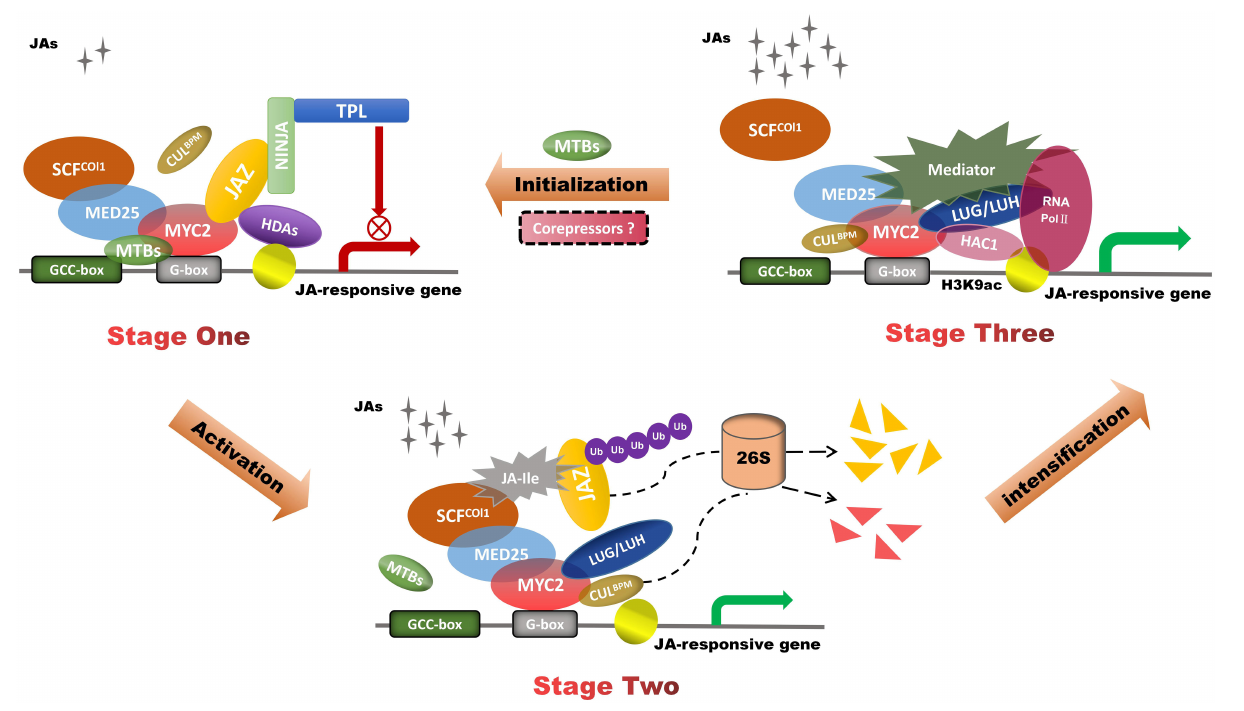
FIGURE 2 | JAZ and MED25 mutually regulate JA-induced transactivation of MYC2-targeted genes. In Stage one, the MED25–MYC2 interaction is relatively weak because JAZ competes with MED25 for interaction with MYC transcription factors. In Stage two, COI1–JAZ co-receptor complex leads to proteasome-dependent degradation of JAZ repressors, which participate in the degradation of JAZ by 26S proteasome. In Stage three, MED25 recruits Pol II and LUH to the promoter of the MYC2-targeted gene, thereby regulating their expression. LUH enhanced the interactions of MYC2 coupled with its co-activators MED25 and HAC1. MTBs competitively interact with MYC2-targeted genes and impair the MED25–MYC2 complex. CUL3 BPM reduce MYC levels by the ubiquitination of MYC